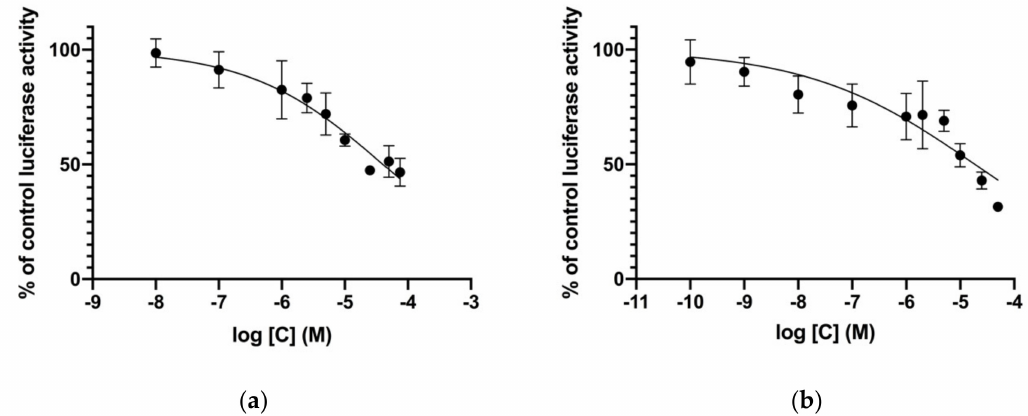
Figure 4. Dose-response curves for Endocrine Disruptome (ED)-predicted antagonist activities in luciferase reporter cell lines for: ( a ) irinotecan on GR in the MDA-kb2 cell line and ( b ) palonosetron on AR in the AR-EcoScreen cell line. Mean and SD of at least three independent experiments are